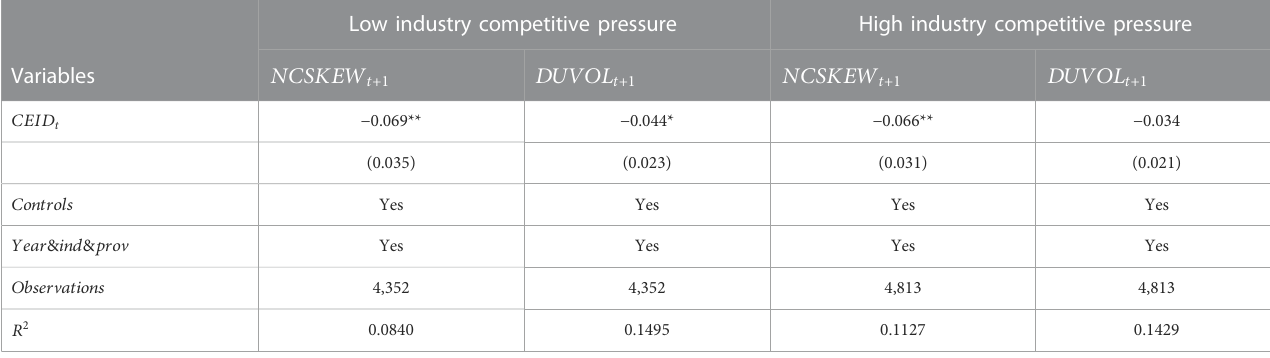
TABLE 9 Motivation of environmental information disclosure.